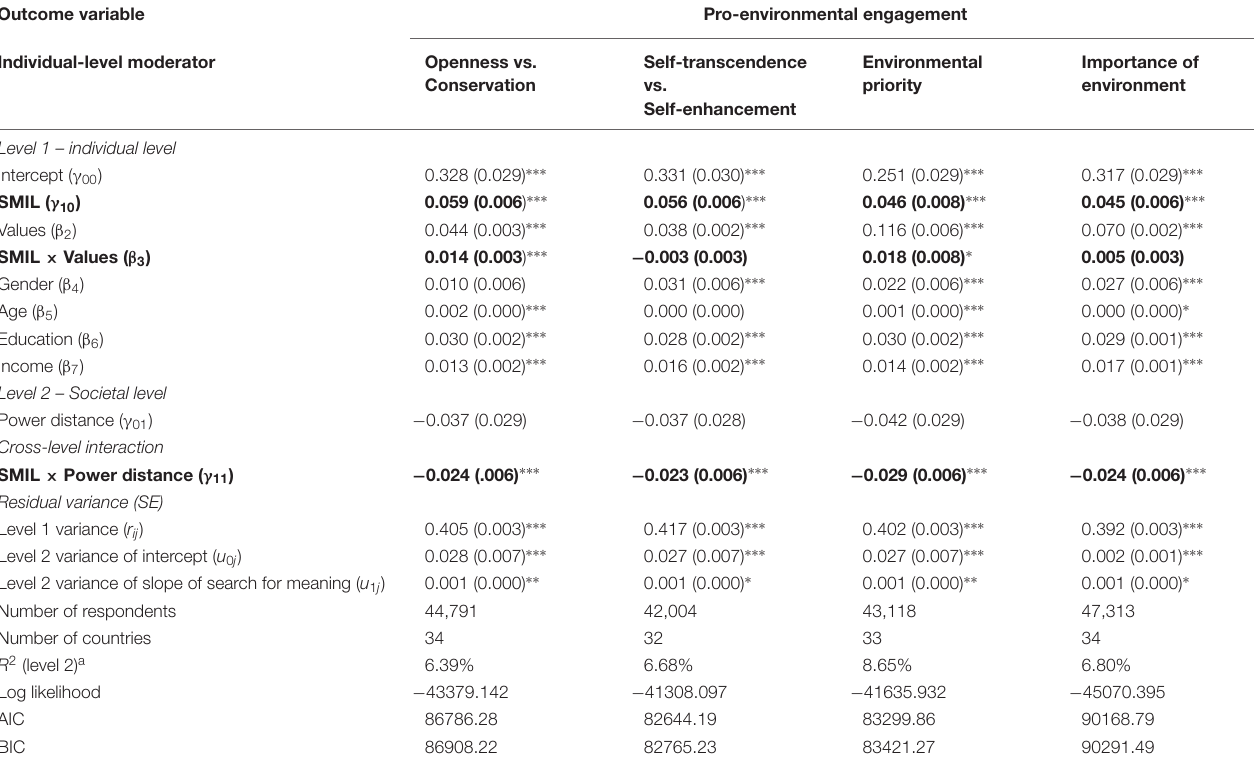
TABLE 1 | Final models of pro-environmental